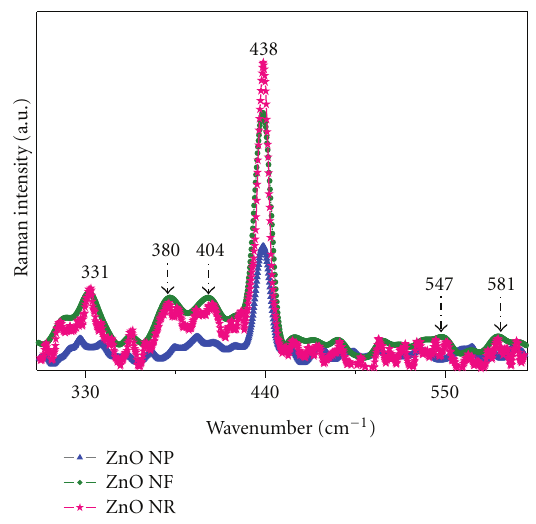
Figure 5: Raman spectra of ZnO nanoparticles, nanoflowers, and nanorods